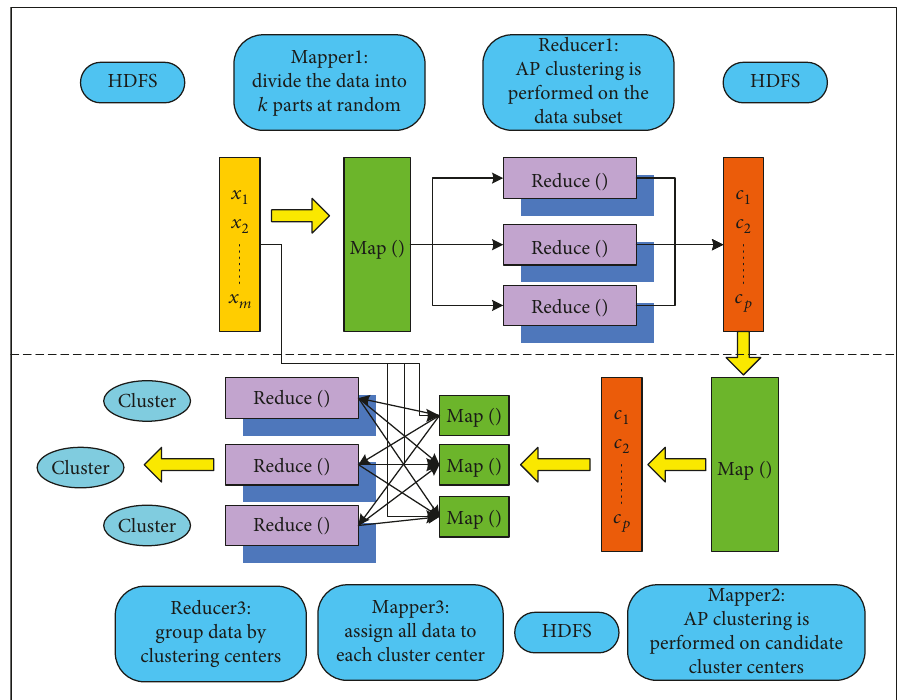
Figure 5: Implementation of distributed AP clustering based on